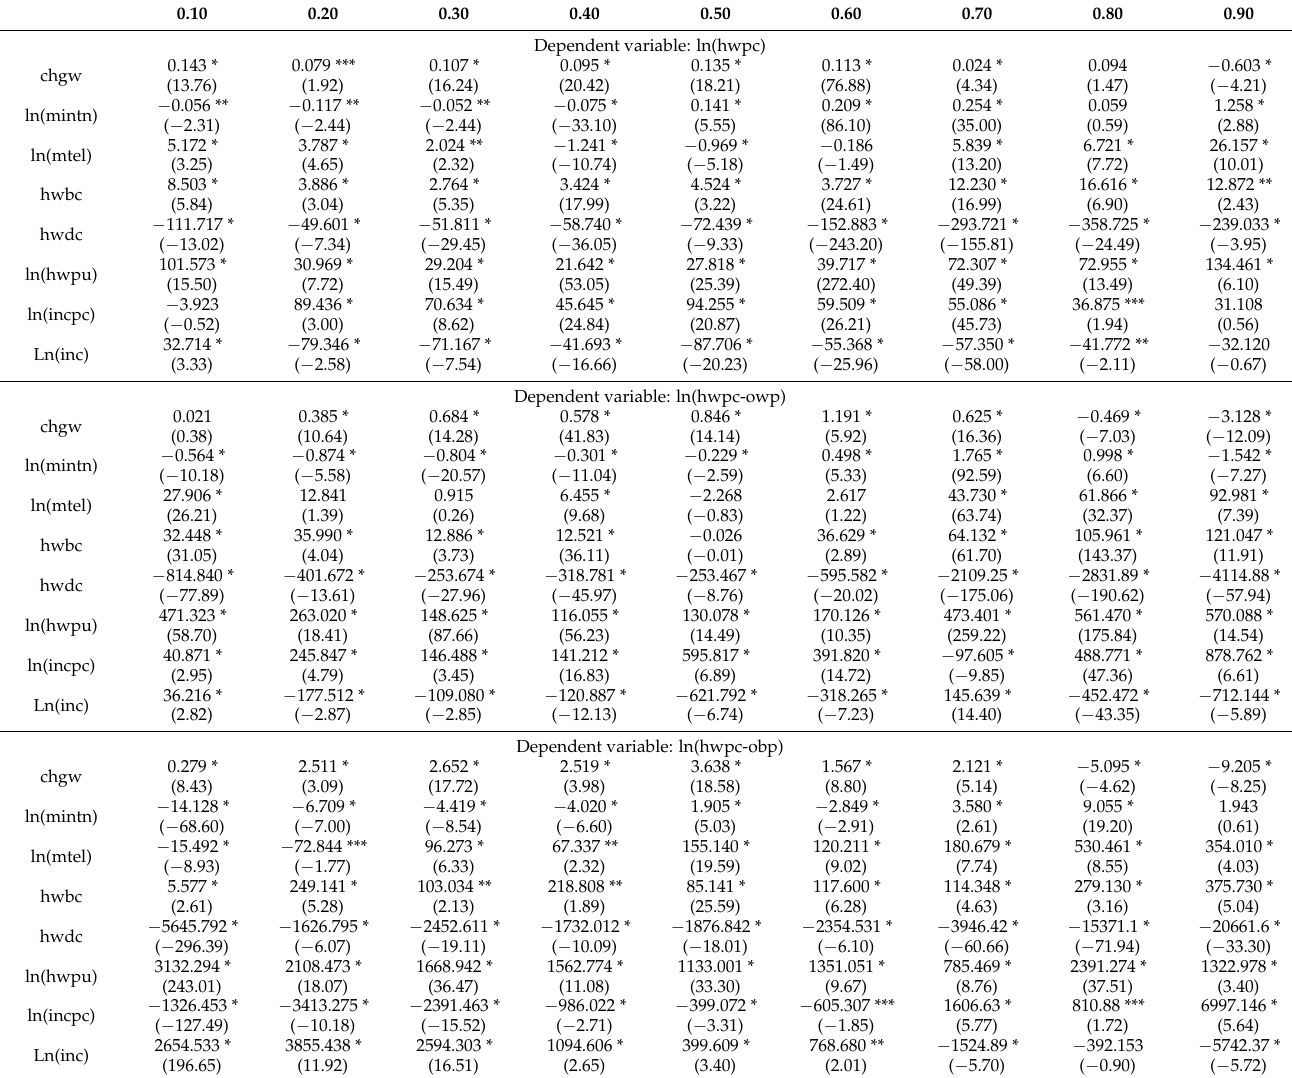
Table 6. Robustness results of health and wellness food consumption per